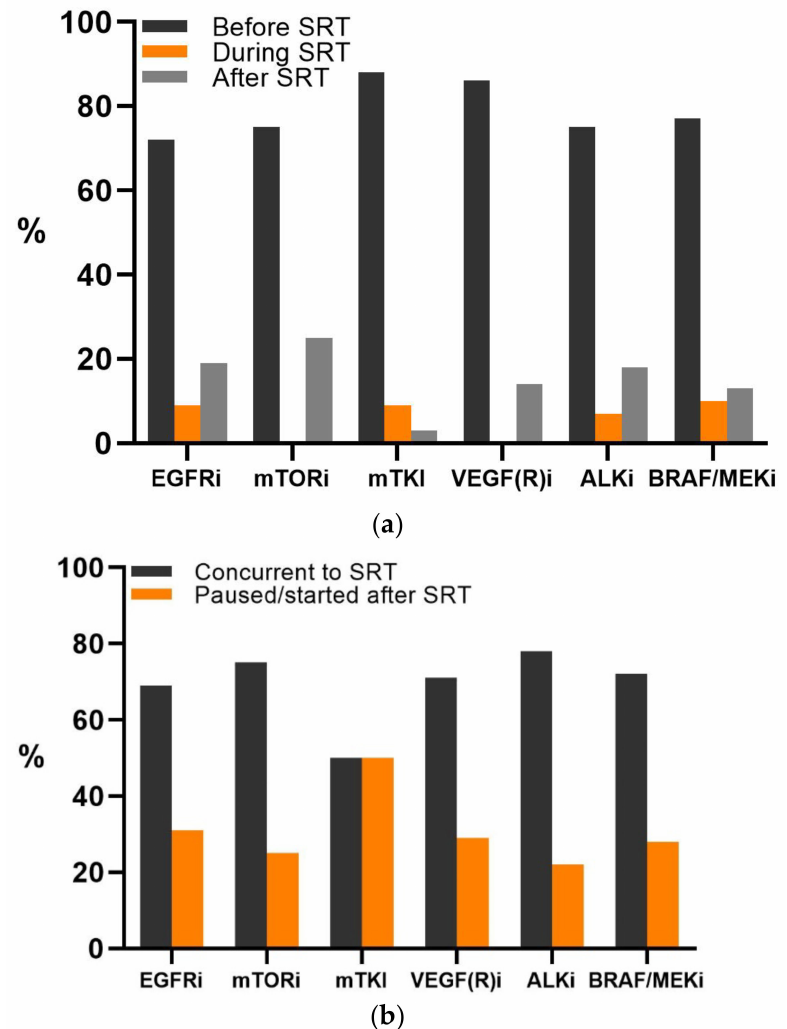
Figure 1. ( a ) Timing of the start of targeted therapy (TT) in relation to stereotactic radiotherapy (SRT) in included patients. ( b ) The number of patients in which TT was interrupted or continued during SRT, as per TT